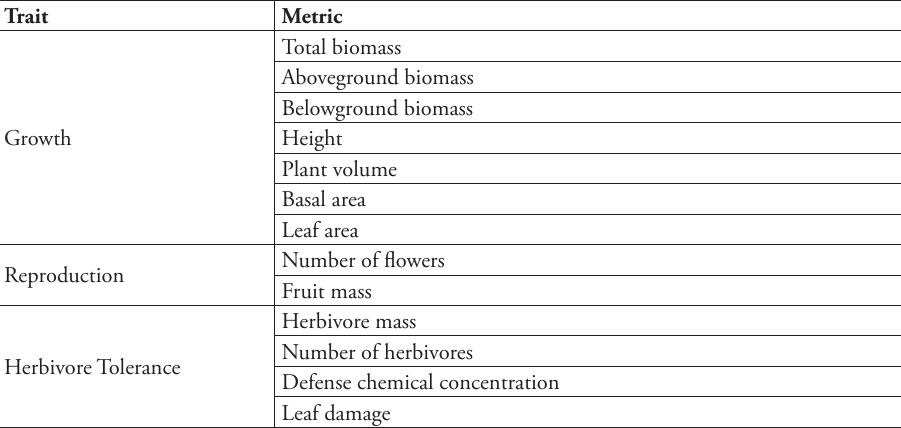
table 3. The metrics used to quantify growth, herbivore tolerance and reproduction in studies examining post-establishment evolution. Data are aggregated from our review of design parameters detailed in Table 2.